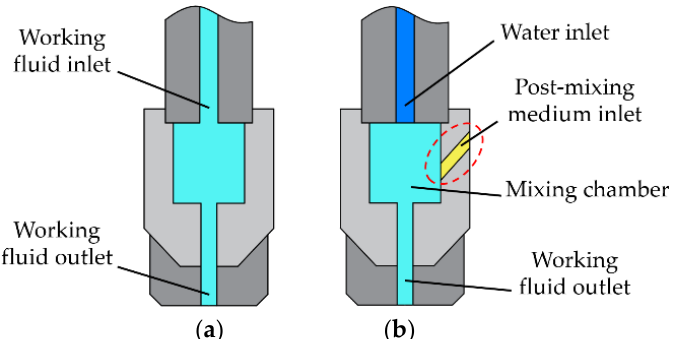
Figure 2. Different jet nozzle structures of two mixing methods: ( a ) Pre-mixing jet nozzle; ( b ) Post-mixing jet nozzle.